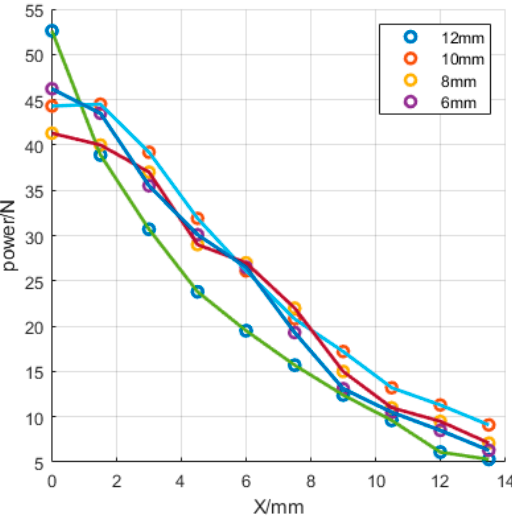
Figure 24. Changes in pressure under different trajectories.